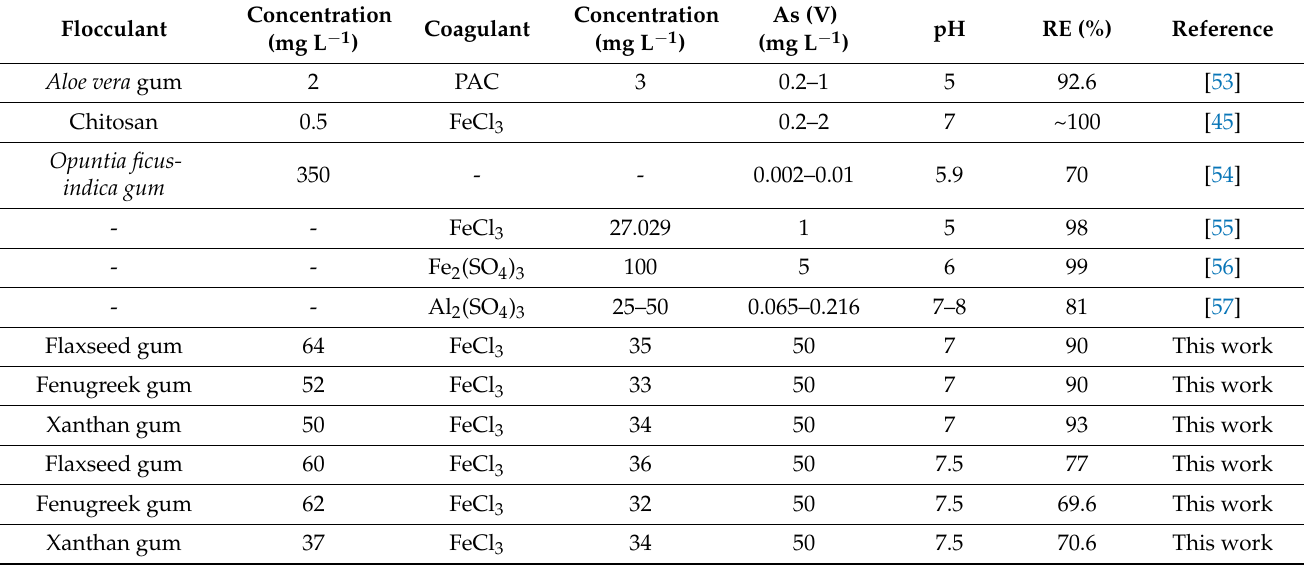
Table 4. Comparison of maximum RE (%) of arsenic in aqueous medium using different